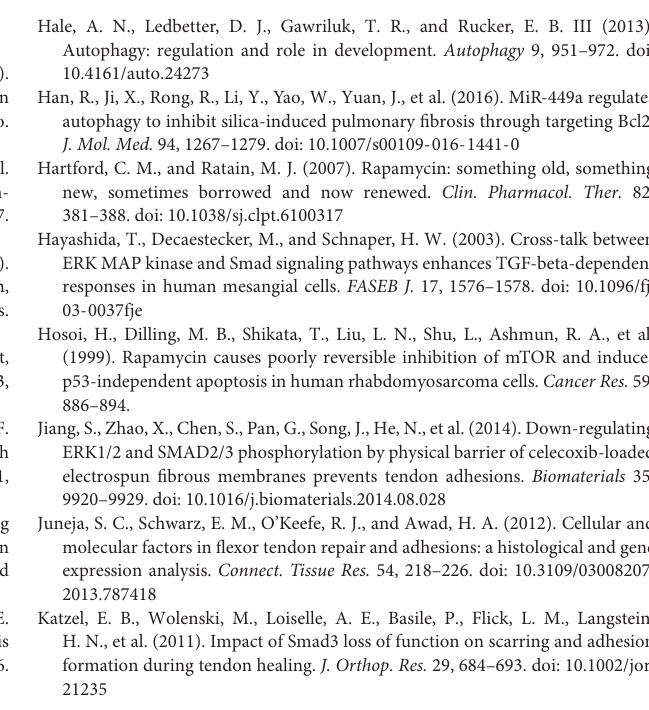
FIGURE S1 | Autophagy activity after shame operation. Representative images of western blot analysis of LC3A/B and p62 expression levels after DMSO/rapamycin treatment in shame operation rats. n = 3 in each group. FIGURE S2 | Original images of western